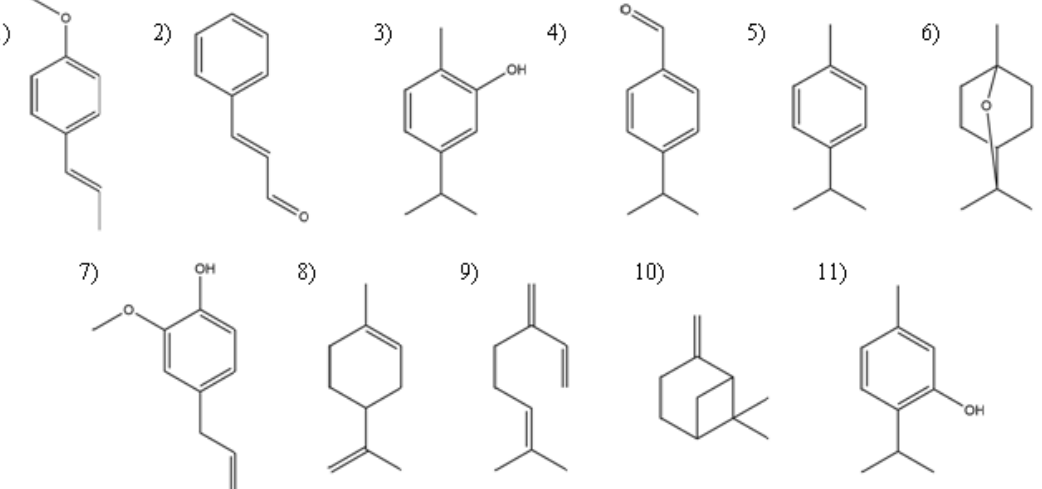
Figure 1. Chemical structure of major components (these are analytical standards purchased from Sigma-Aldrich as mentioned in the experimental section) evaluated: ( 1 ) trans-Anethole; ( 2 ) Cinnamaldehyde; ( 3 ) Carvacrol; ( 4 ) Cuminaldehyde; ( 5 ) p-Cymene; ( 6 ) Eucalyptol; ( 7 ) Eugenol; ( 8 ) (-)-Limonene; ( 9 ) β -Myrcene; ( 10 ) β -Pinene; and